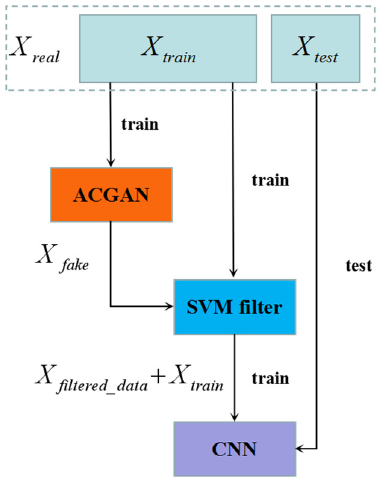
Figure 4. ACGAN ‐ SVM ‐ CNN. Figure 4.